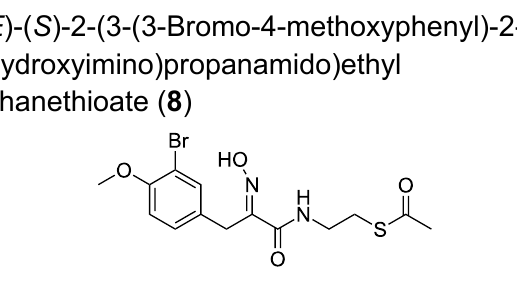
Figure 2: rHDAC1 was incubated with a predetermined IC 50 concentration of 7 (left) and 9 (right) for 1–60 minutes, and the remaining rHDAC1 activity (Y-axis, %) was recorded and plotted as a function of the incubation time (X-axis, minutes).